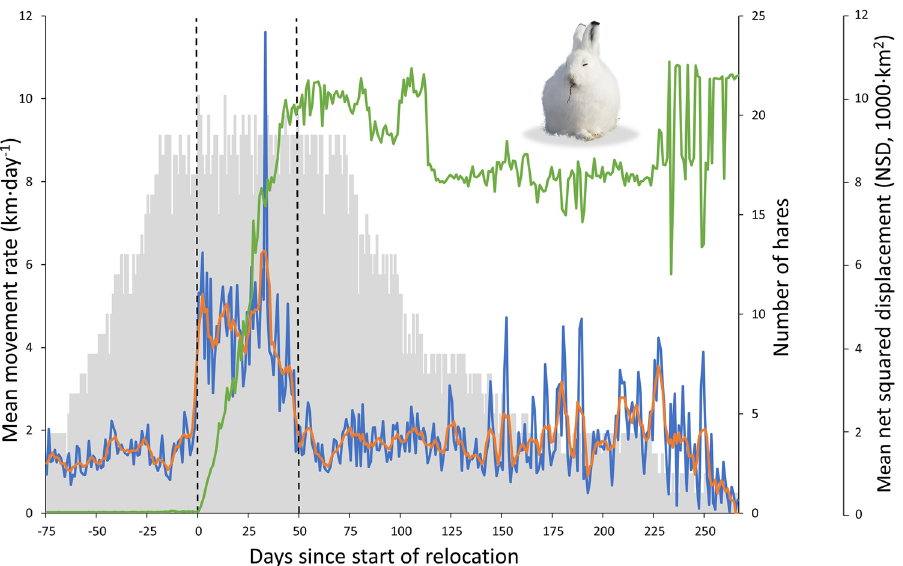
Figure 3. Variation through time of the mean movement rate and mean net squared displacement (NSD) of Arctic hares equipped with Argos satellite collars at Alert (Nunavut, Canada). Departure dates of individuals from their summer grounds ranged from 11 August 2019 to 17 September 2019 (on average 26 August 2019) and were considered as day 0 before plotting. Mean daily movement rates (blue line) and 5-day moving average of daily movement rates (orange line) are shown from day − 75 (on average 27 June 2019) to day 266 (on average 30 May 2020). Mean net squared displacement (NSD, green line) is shown for the same period. The number of hares contributing data to a given day is shown as a gray bar. Vertical dashed lines indicate the average start (day 0) and end (day 50, on average 15 October 2019) of relocation of tracked hares. Note the sharp increase of movement rates and NSD when relocation begins, but the more gradual change when relocation ends, due to individual differences in length of the relocation